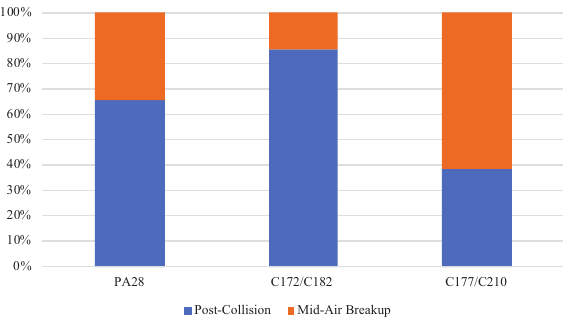
Figure 1. Post-collision vs. mid-air breakups in PA28s, C172/ C182s, and C177s/C210s